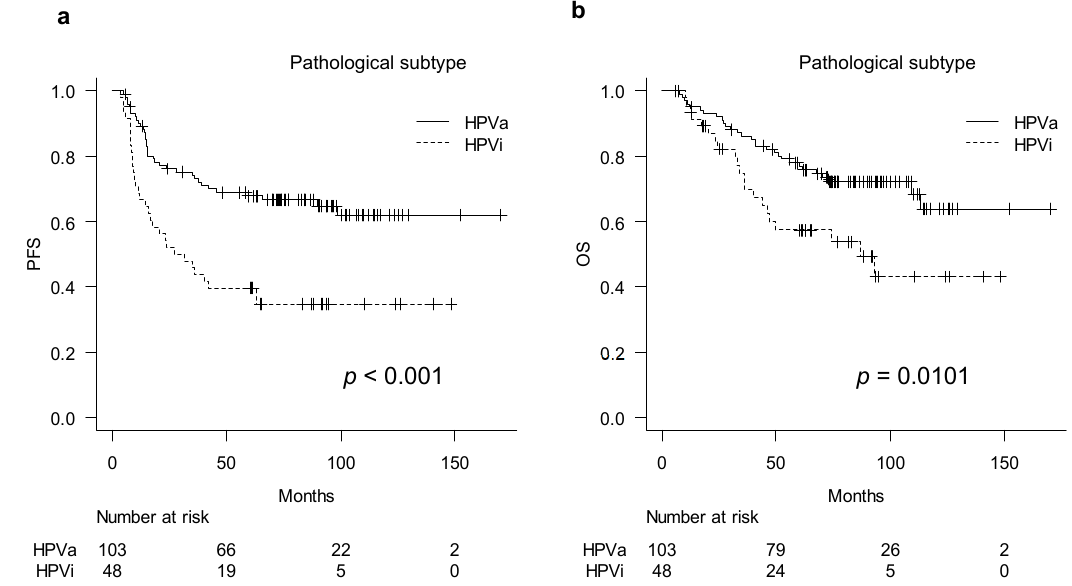
Figure 1. Survival curves of HPV-associated and HPV-independent tumor: ( a ) Kaplan–Meier curve describing progression-free survival and ( b ) overall survival of each group. HPVa, human papilloma virus-associated; HPVi, human papilloma virus-independent; PFS, progression-free survival. Table 2. Analysis of prognostic factors by univariate and multivariate analysis: (a) progression-free survival and (b) overall survival.